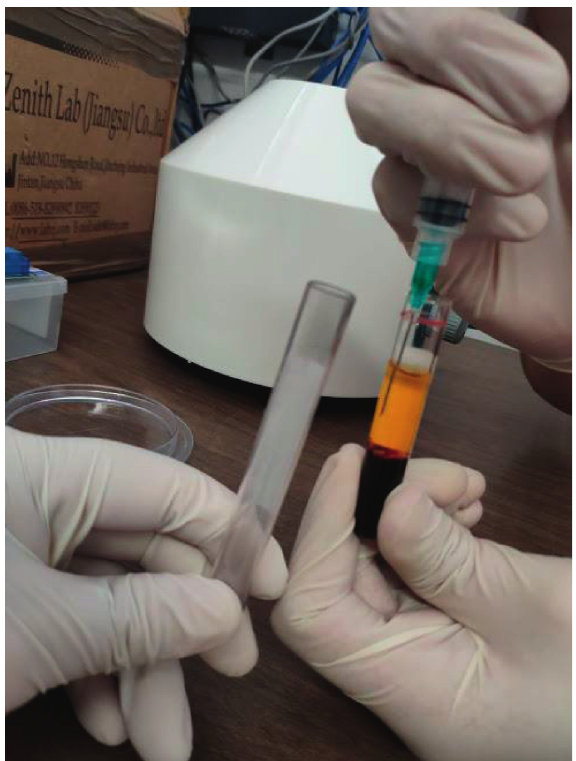
Figure 3: Extraction of blood plasma.